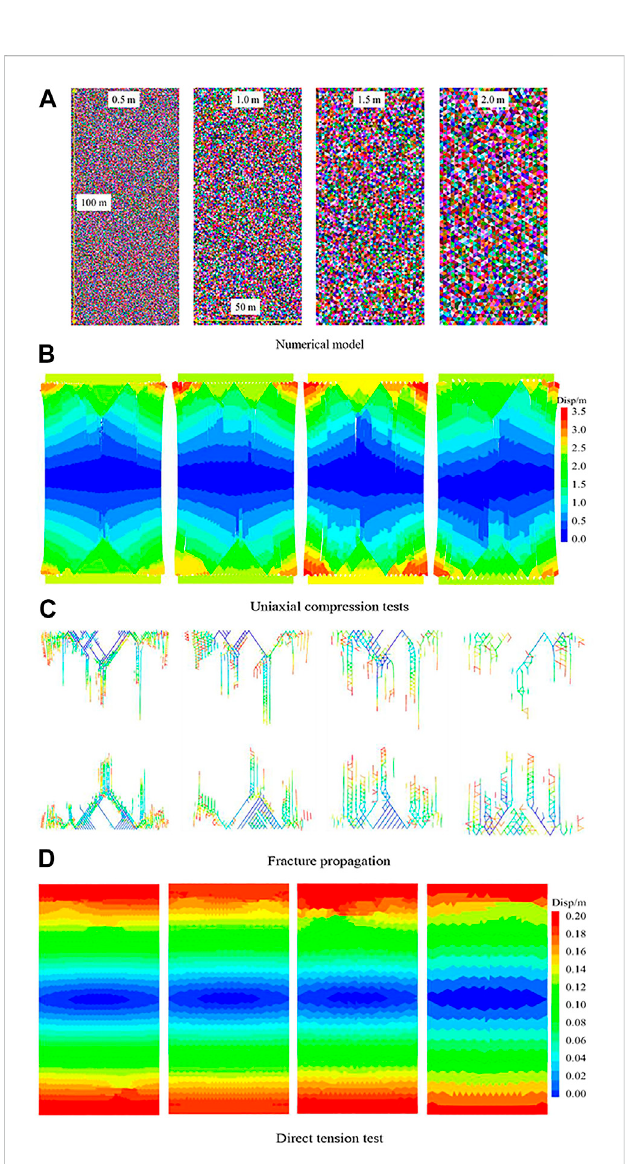
FIGURE 7 Rock mass strength test results. (A) Numerical model. (B) Uniaxial compression tests. (C) Fracture propagation. (D) Direct tension